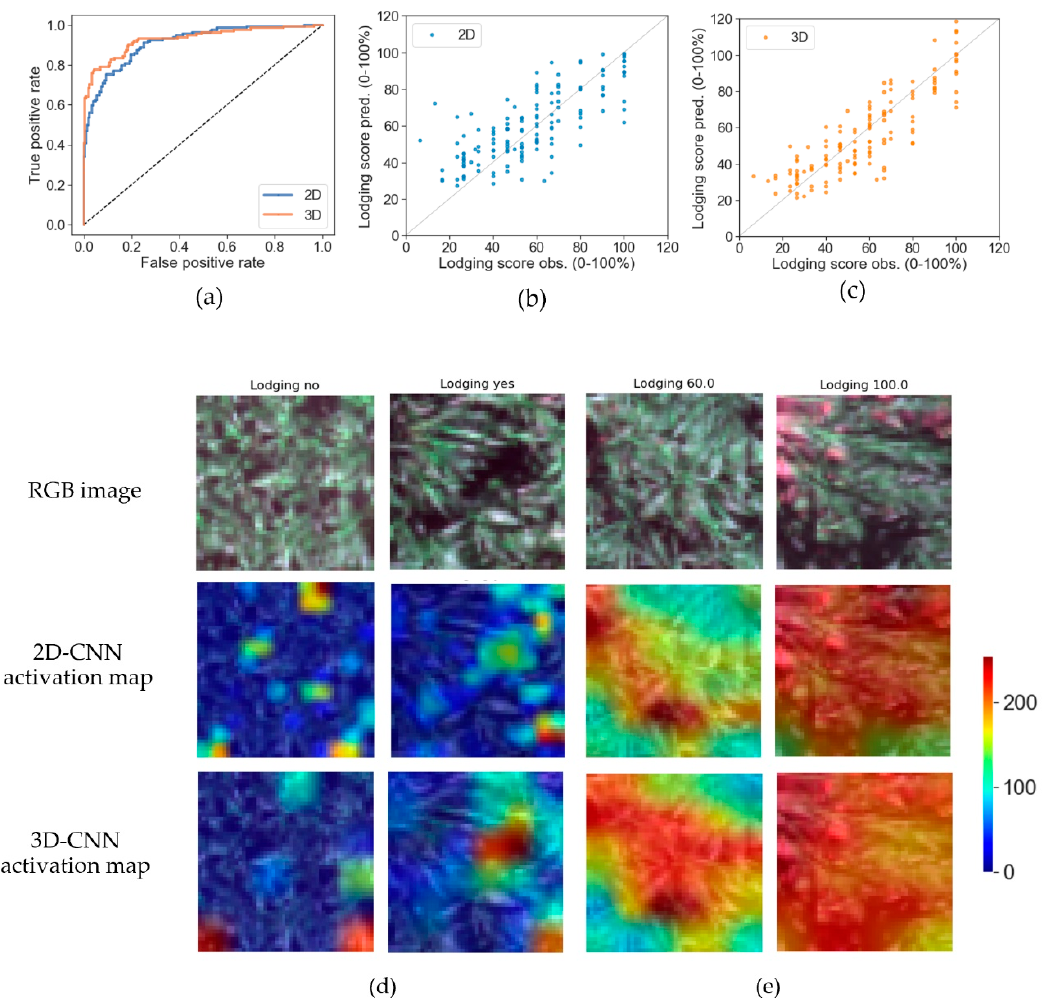
Figure 6. Evaluation of best CNN models on lodging detection prediction in testing dataset via ROC curves ( a ) and observed and predicted severity values for 2D-CNN ( b ) and 3D-CNN ( c ), respectively. Visual representation of activation maps of last max pooling layer of each CNN for lodging detection ( d ), and lodging severity ( e ) assessment. Example RGB image of plots (top), corresponding gradient activation maps of best 2D-CNN (middle), and best 3D-CNN (bottom) in testing dataset. The level of activation of CNN layers in the images is represented by low (blue), intermediate (yellow), and high (red) using an 8-bit (0-255) scale.